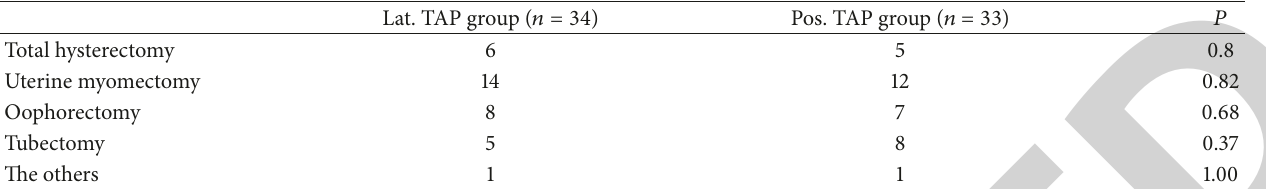
Table 2: Surgery contents. 𝑃 calculated by using Fisher’s exact test.